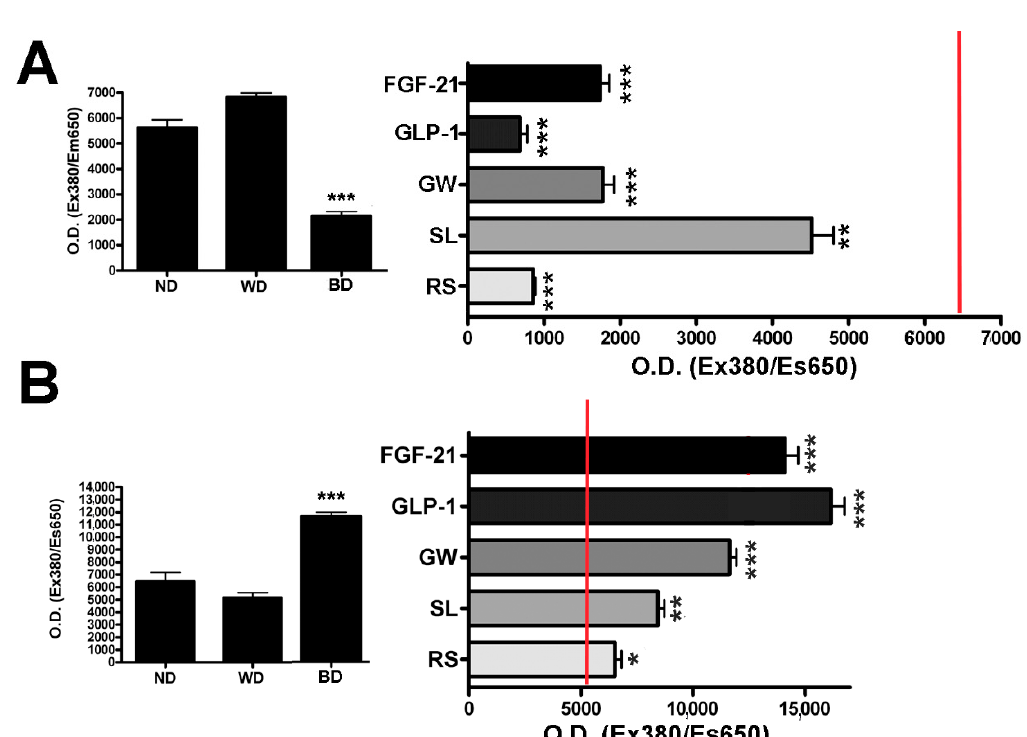
Figure 6. Evaluation of cellular mitochondrial function by oxygen consumption assay. ( A ) Histogram on the left show ATP production in white adipocytes (white differentiation, WD) compared to MSCs grown without differentiation cues (ND). Histogram on right shows mitochondrial ATP production in presence of all tested compounds during white adipogenic differentiation. ( B ) Histogram on the left shows proton leak level in white adipocytes (WD) compared to MSCs grown without differentiation cues (ND). Histogram on right shows the proton leak level in the presence of all tested compounds during white adipogenic differentiation. ( ± SD, n = 5 biological replicates; * p < 0.05, ** p < 0.01, *** p < 0.001). ND: no differentiation cues; WD: white differentiation; BD: brown differentiation; FGF-21: fibroblast growth factor-21; GLP-1: glucagon-like peptide-1; GW: GW501516; SL: sildenafil; RS: rosiglitazone. For browning agent details, refer to Table